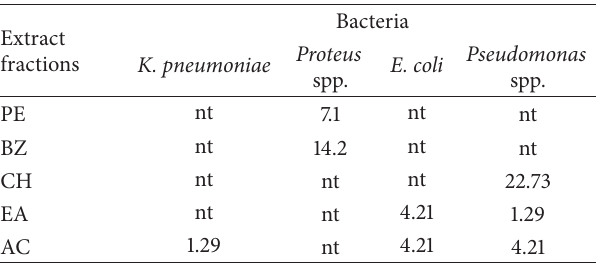
Table 4: Minimum bactericidal concentration (MBC) of potential extracts derived from T. cordifolia stem.